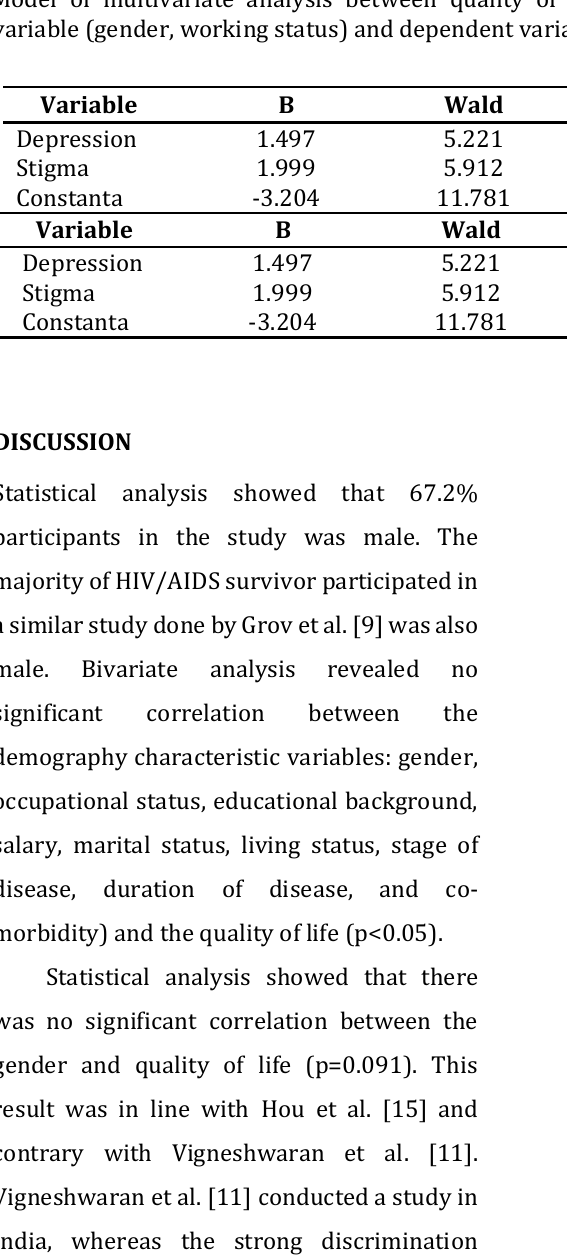
Model of multivariate analysis between quality of life (independent variable) and cofounding variable (gender, working status) and dependent variable (depression,